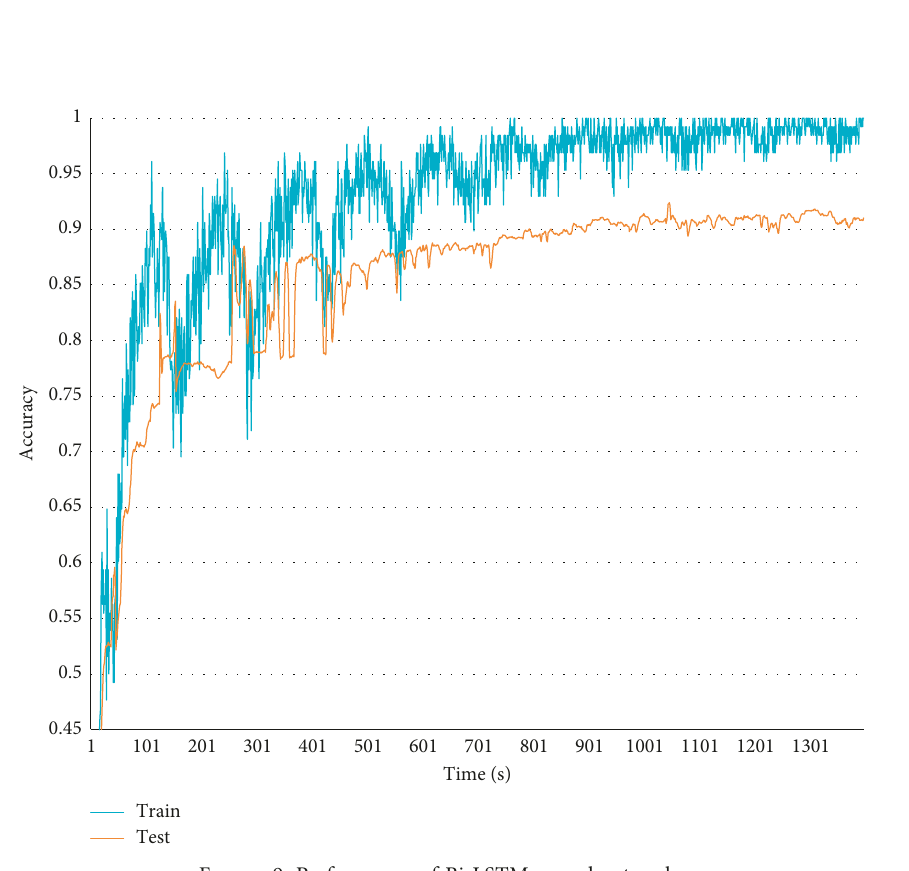
Figure 9: Performance of Bi-LSTM neural network.